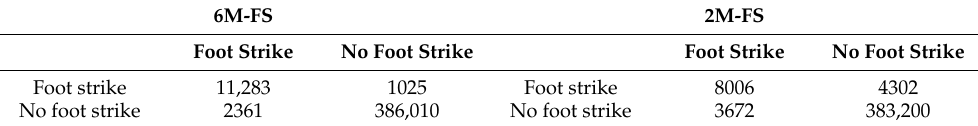
Table 3. Foot strike classification.